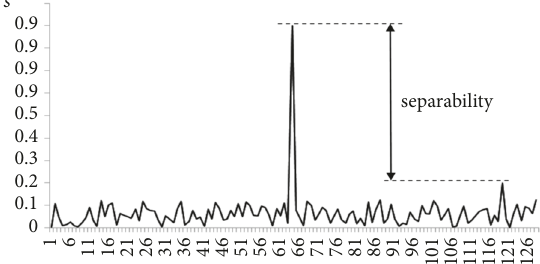
Figure 4: Separability in a Robust Watermarking